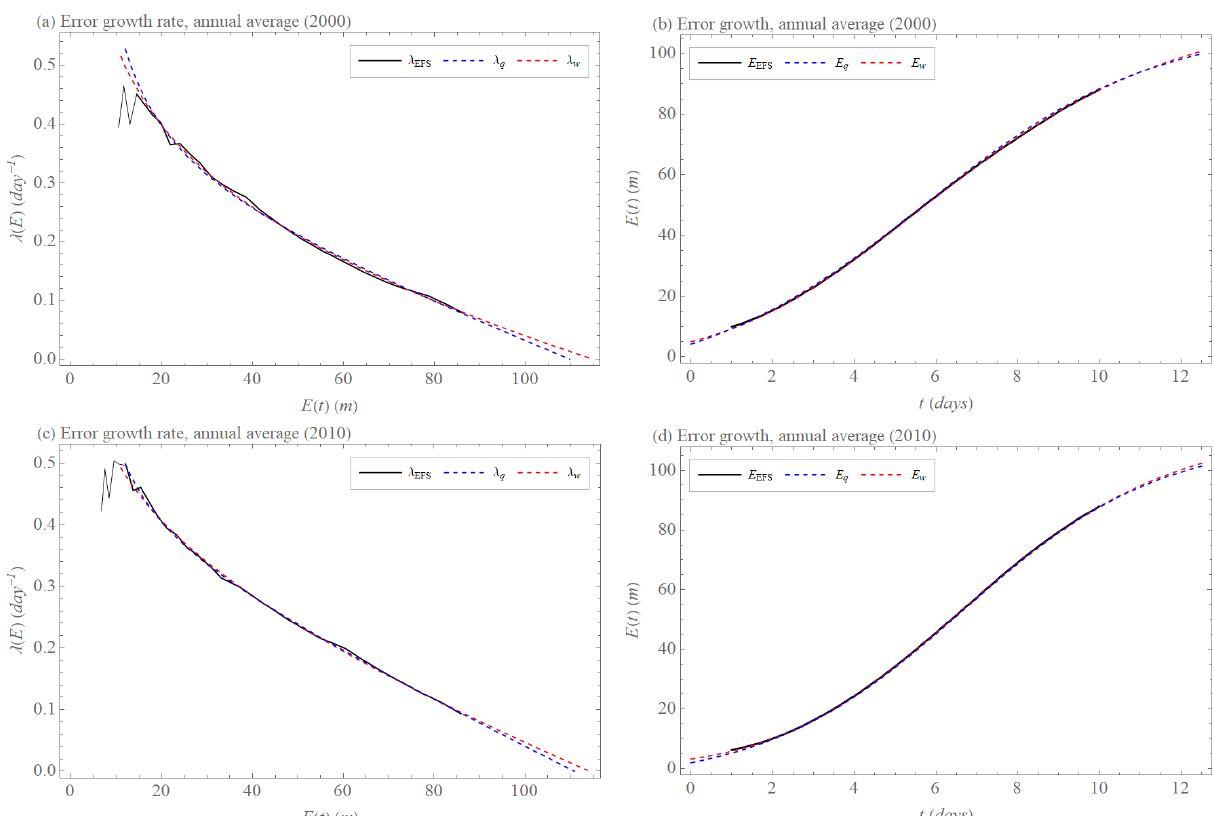
Figure 5. The error growth rate λ EFS (E) and error growth E EFS (t) of the ECMWF forecasting system’s 500hPa geopotential height values (Northern Hemisphere, 20–90 ◦ ) calculated as differences between two operational forecasts issued with 1d lag but valid on the same day (black), approximation by the extended power law λ w (E) (Eq. 26) and E w (t) (Eq. 27) (red, dashed), and approximation by the extended quadratic model λ q (E) (Eq. 20) and E q (t) (Eq. 21) (blue, dashed). (a,b) Annual average of 2000, λ EFS , w (E) and E EFS , w (t) with σ = 0.28, a = 1.1(m 0 . 28 d − 1 ), and E ∞ = 115(m), λ EFS , p (E) and E EFS , p (t) with α = 0.32(d − 1 ) and β = 3.2(md − 1 ) and E ∞ = 110(m). (c,d) An- nual average of 2010, λ EFS , w (E) and E EFS , w (t) with σ = 0.17, a = 0.8(m 0 . 17 d − 1 ), and E ∞ = 114(m), λ EFS , p (E) and E EFS , p (t) with α = 0.4(d − 1 ) and β = 2(md − 1 ) and E ∞ =